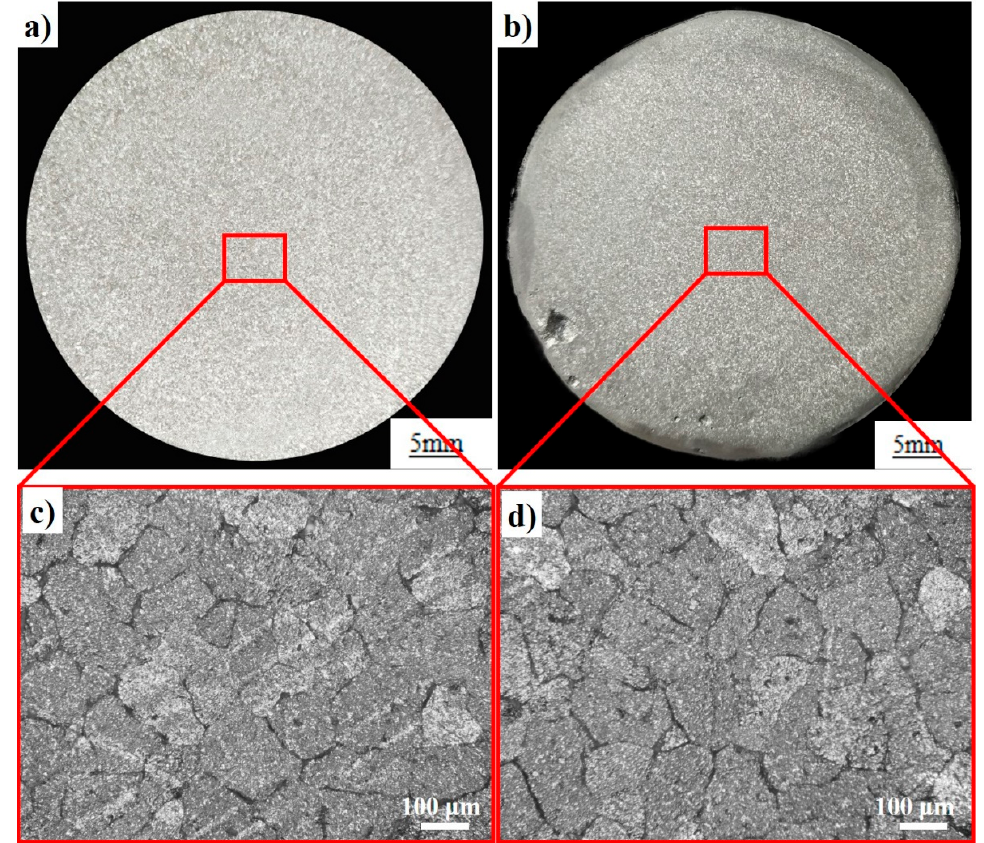
Figure 9. Macrostructures of pure aluminum refined by the ( a ) Al-5Ti-0.25C and ( b ) Al-5Ti-1B master